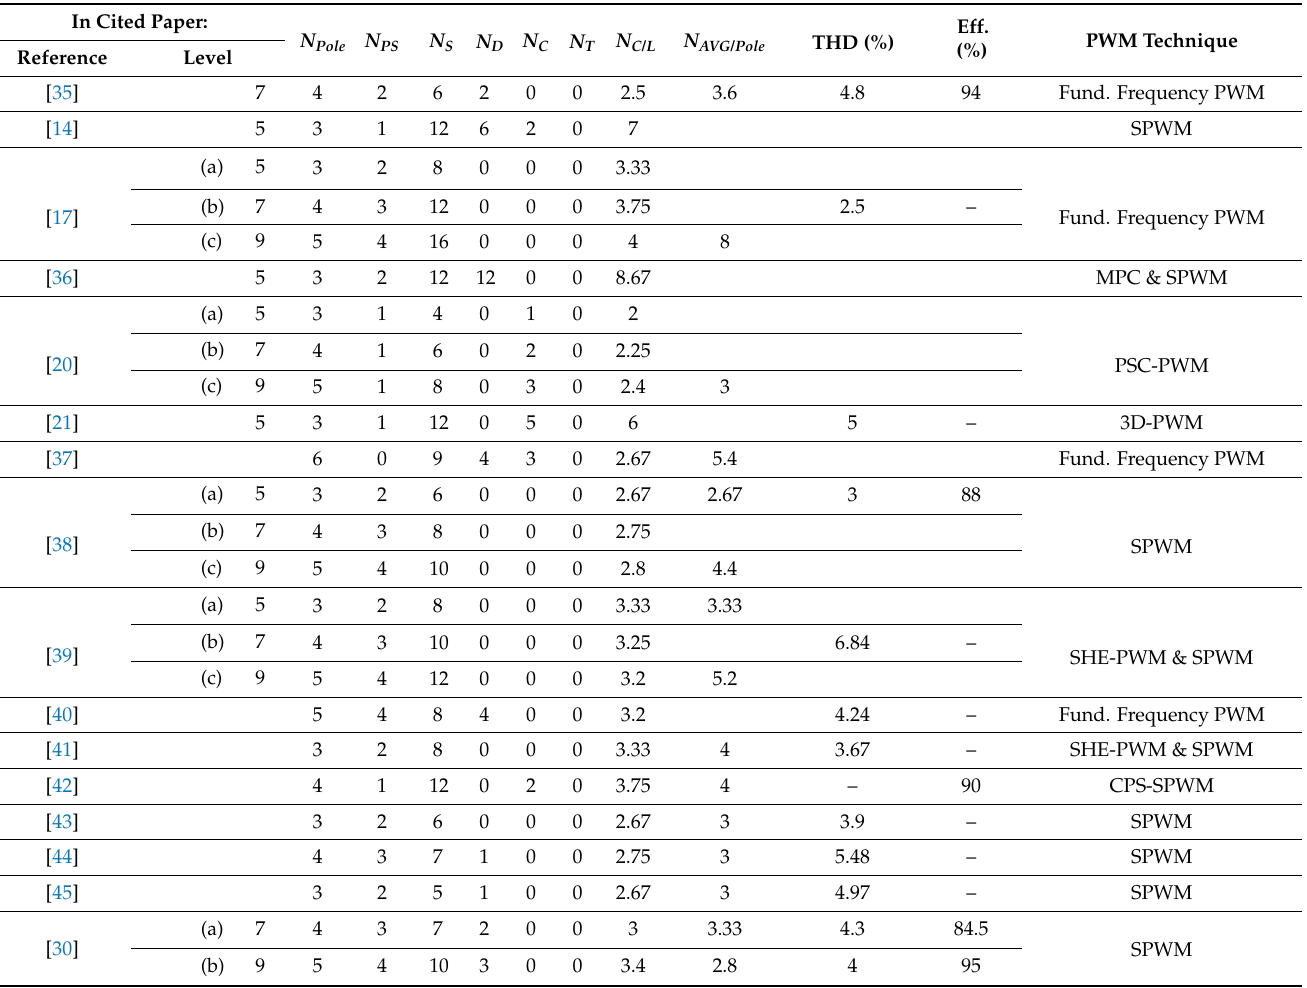
Table 2. Comparison study of MLI